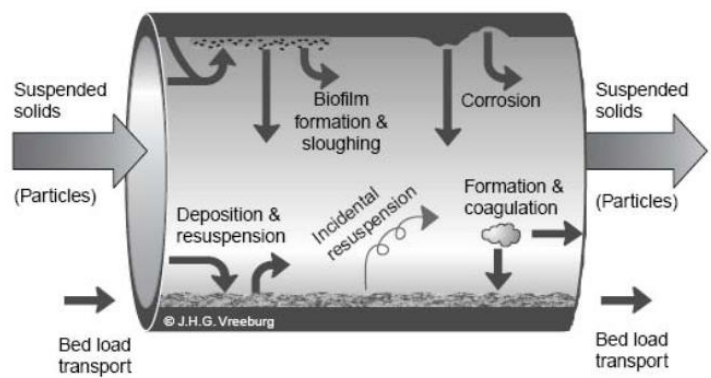
Figure 1. Overview of processes in the DW DS influencing water quality [115].